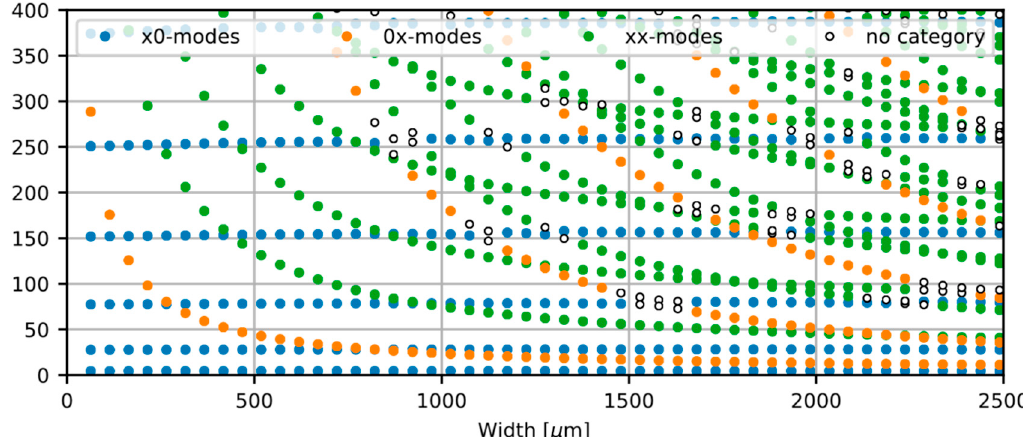
Figure 2. The resonance frequencies of the eigenmodes of the cantilever described in Figure 1 as a function of cantilever width. The colors of the markers indicate the mode categorization. White markers are used for modes that do have two or more dominant Fourier component. These cases typically occur when two eigenfrequency approach each other